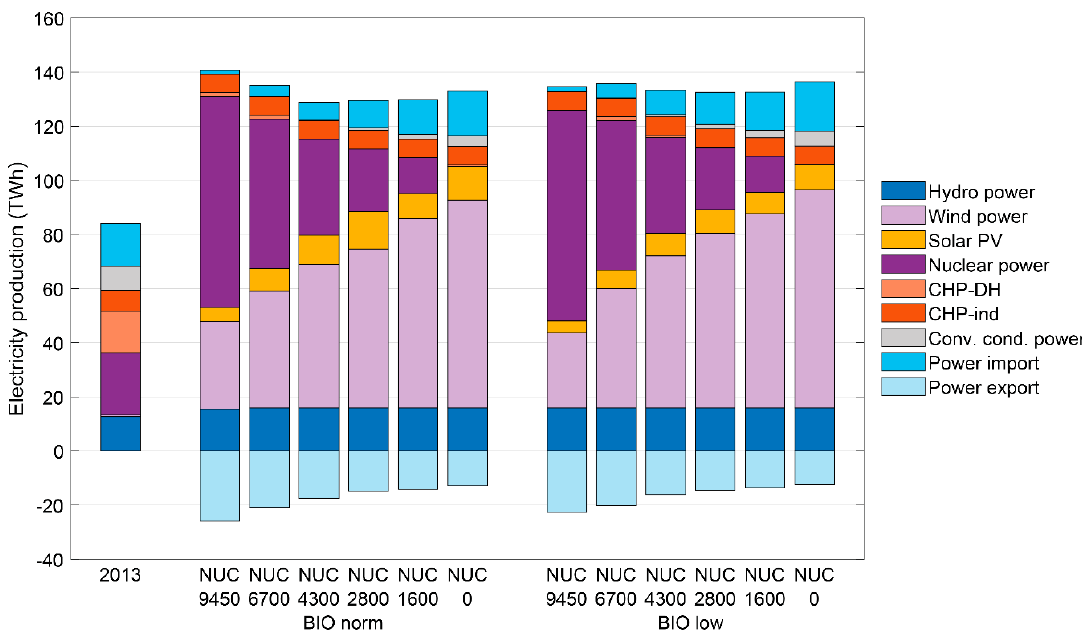
Figure 2. Electricity production of the national case, without (“BIO norm”) and with biomass limitations (“BIO low”). The reference case, Finland in 2013, is shown on the left.